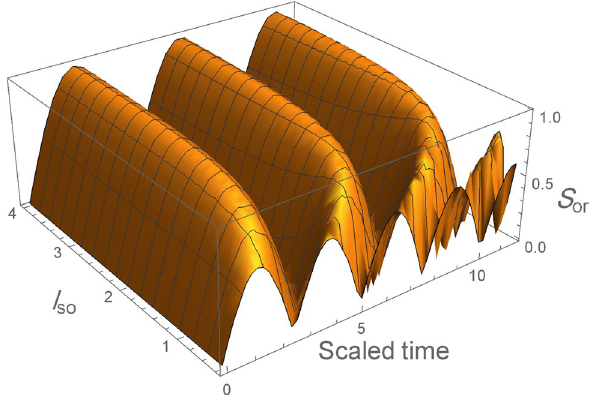
Figure 10. The orthogonality, S or , as a function of spin-orbit coupling ( l so ) when the system’s initial state in the